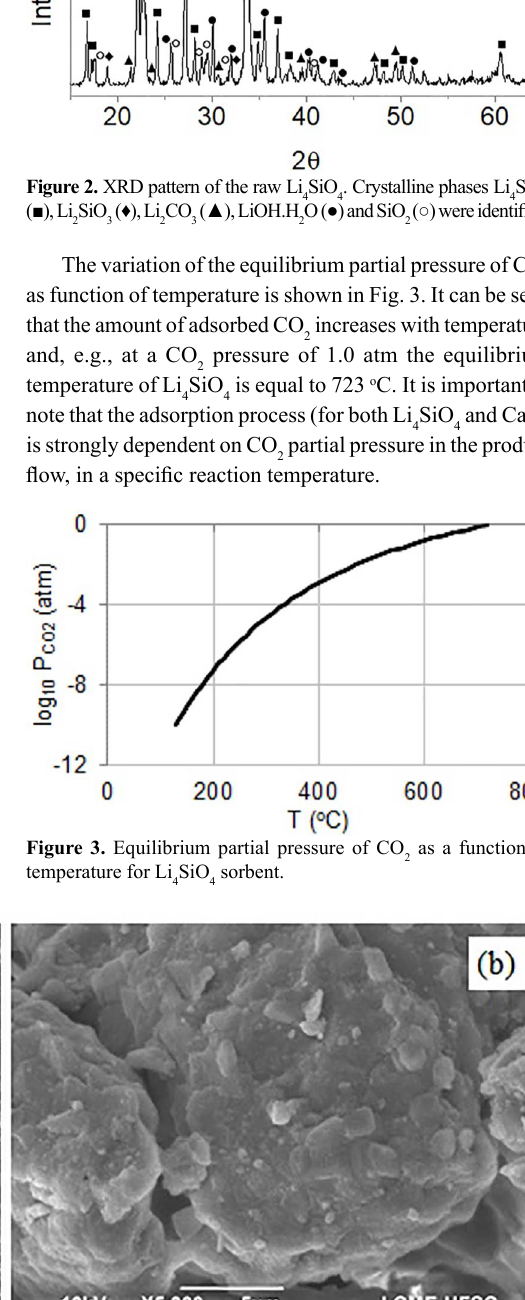
SiO with approximations of 100x (a) and 5000x (b). 4 4